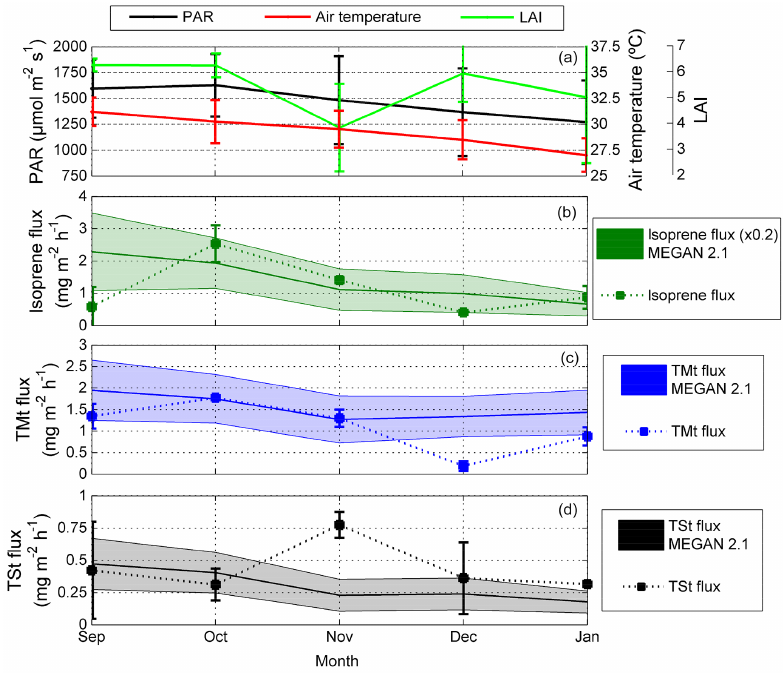
Figure 5. Monthly averages of air temperature and PAR (measured at K34 tower during 10:00–14:00, LT), and LAI (MODIS, 8-day ob- servations) (a) . Monthly averages of fluxes of isoprene (b) , total monoterpenes (TMt) (c) and total sesquiterpenes (TSt) (d) . Flux based on in situ PTR-MS measurements (inverse Lagrangian transport model – estimates for 10:00–14:00, LT, at TT34 tower) are represented by solid squares and 1 standard deviation; fluxes modeled by MEGAN 2.1 (estimates for 10:00–14:00, LT) are shown by solid lines and filled areas that represent 1 standard deviation. Isoprene flux modeled by MEGAN 2.1 in (b) were divided by five. Error bars represent 1 standard